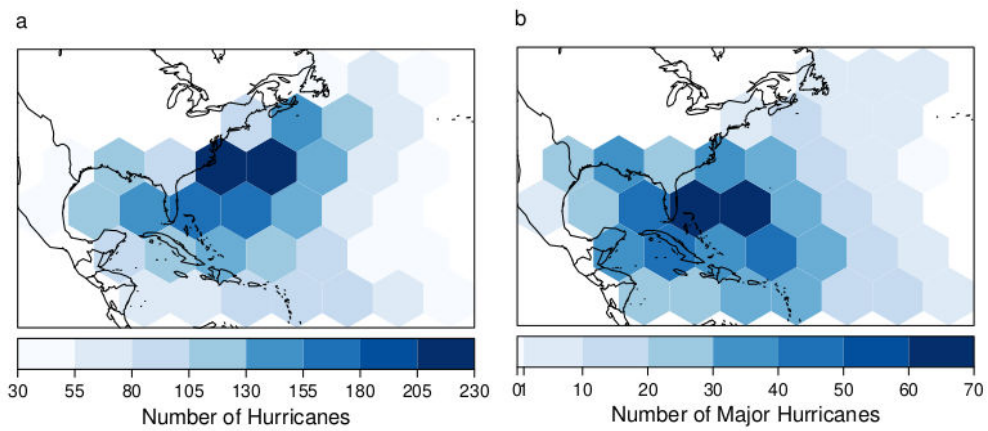
Figure 2. ( a ) Number of hurricanes with winds ≥ 33 ms − 1 in equal-area hexagons from 1854–2018. ( b ) Number of major hurricanes with winds ≥ 50 ms − 1 .